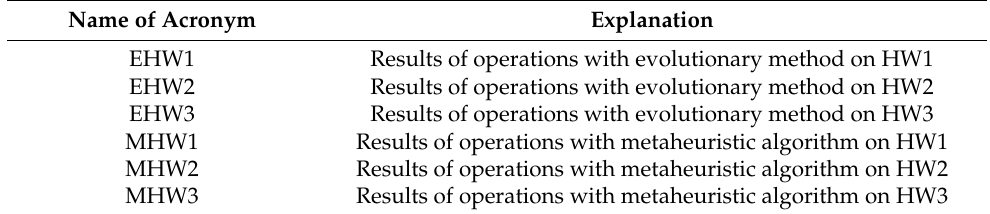
Table 3. Definitions of abbreviations used. Name of